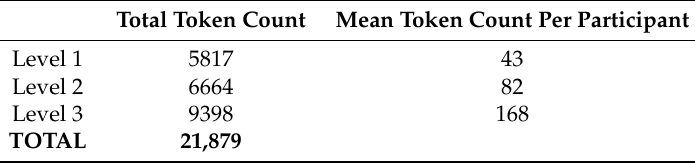
Table 6. Distribution of token counts per L3 level, and mean token count per participant.